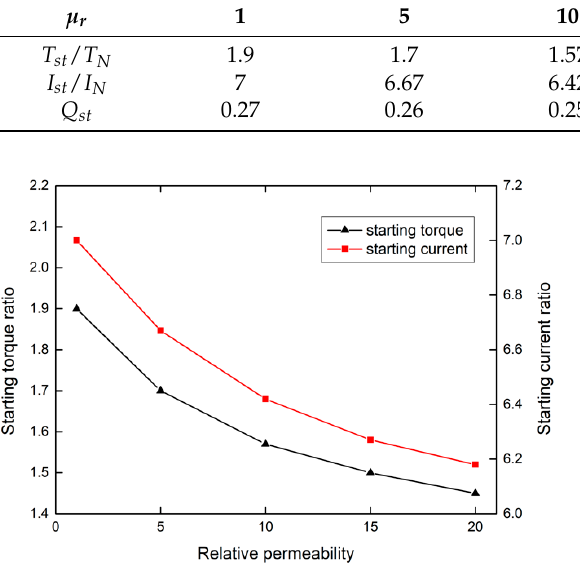
Figure 19. Motor starting performance with different MSWs.